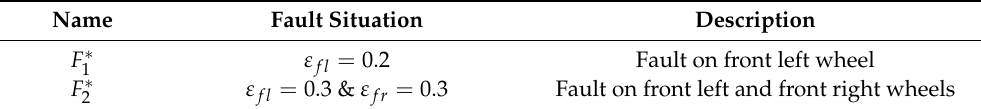
Table 3. Fault situations used during